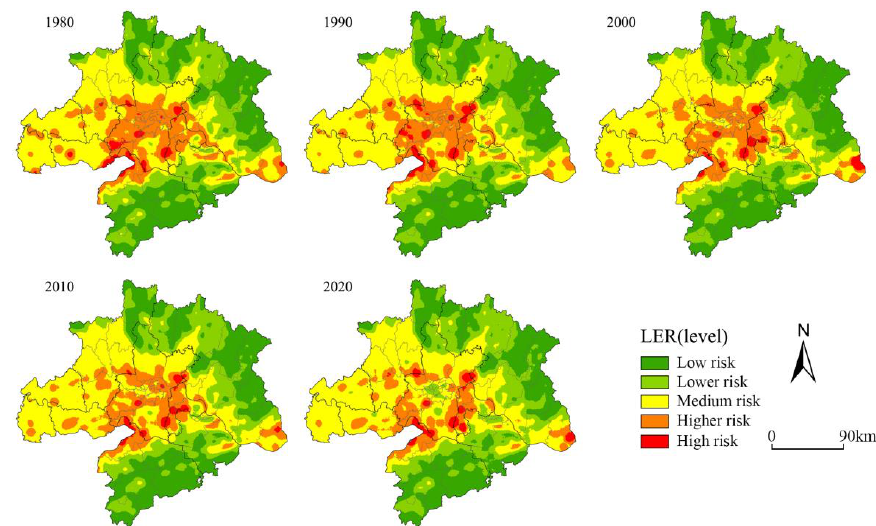
Figure 3. Spatial distribution pattern of landscape ecological risk from 1980 to 2020.